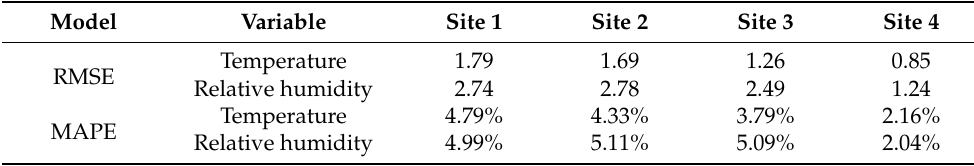
Figure 5. The comparison between measured values and simulation values at 1.5 m from the ground at the four sites for verifying the validity of the ENVI-met software. ( a ) Air temperature. ( b ) Relative humidity. Table 4. Root mean square error (RMSE) and mean absolute error (MAPE) between the observation data and the measured data for temperature and relative humidity at the four